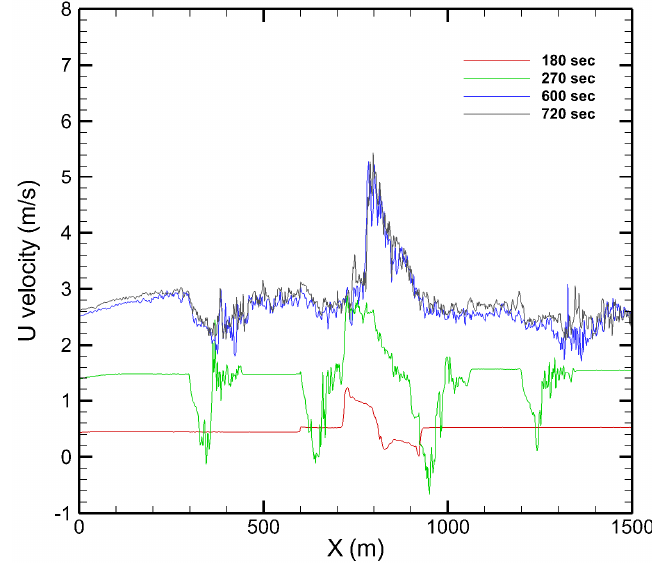
Figure 12. Lengthwise U velocity at symmetry plane y = 5.5 m and z = 3.5 m for Scenario A at different time frames (t = +180 s, +270 s, +600 s, and +720 s).